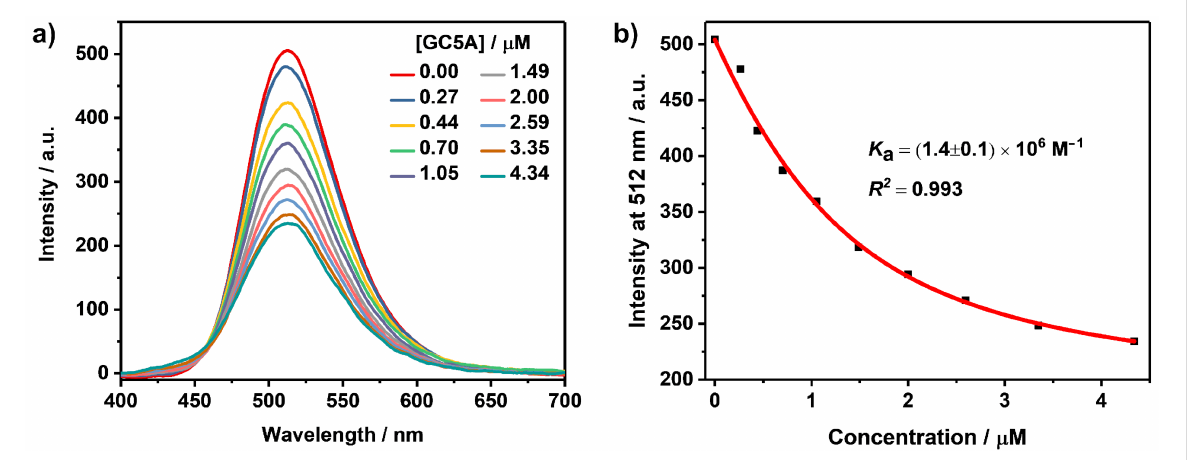
Figure 3: (a) Direct fluorescence titration ( λ ex = 371 nm) of TPS (1.0 μ M) with GC5A in HEPES buffer (10 mM, pH 7.4) at 25 °C and (b) the associat- ed titration curve ( λ em = 512 nm) fitting according to a 1:1 binding